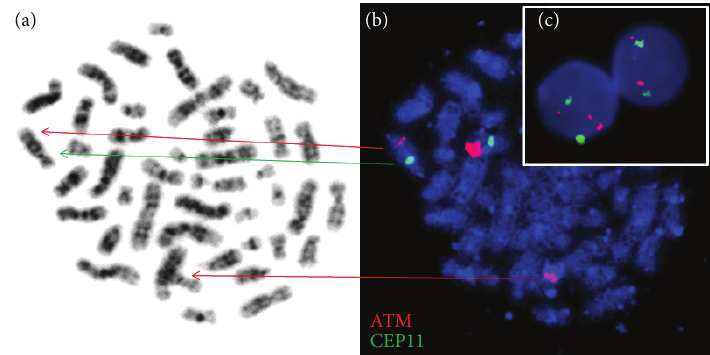
Figure 2: The patient’s bone marrow cell culture. (a) Metaphase staining by Giemsa contains alteration chromosomes 8 and 11 from translocation t(?8;11)(q?13;q22) (indicated by arrows). (b) FISH results with ATM/CEP11 probe on the same metaphase showed rearrangement in 11q22.3 band (two smaller red signals and one normal signal). (c) Interphase FISH results with specific probe ATM/CEP11 reveal three signals (one normal and two smaller signals) for ATM and two typical signals for CEP